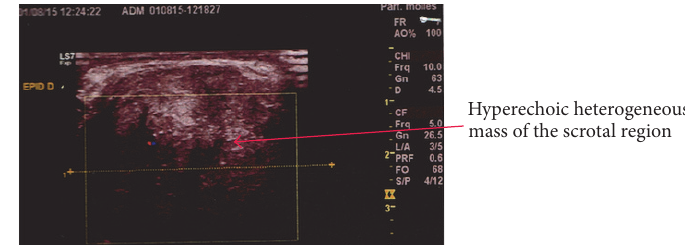
Figure 1: Ultrasonography showing a mass originating from the epidemic right